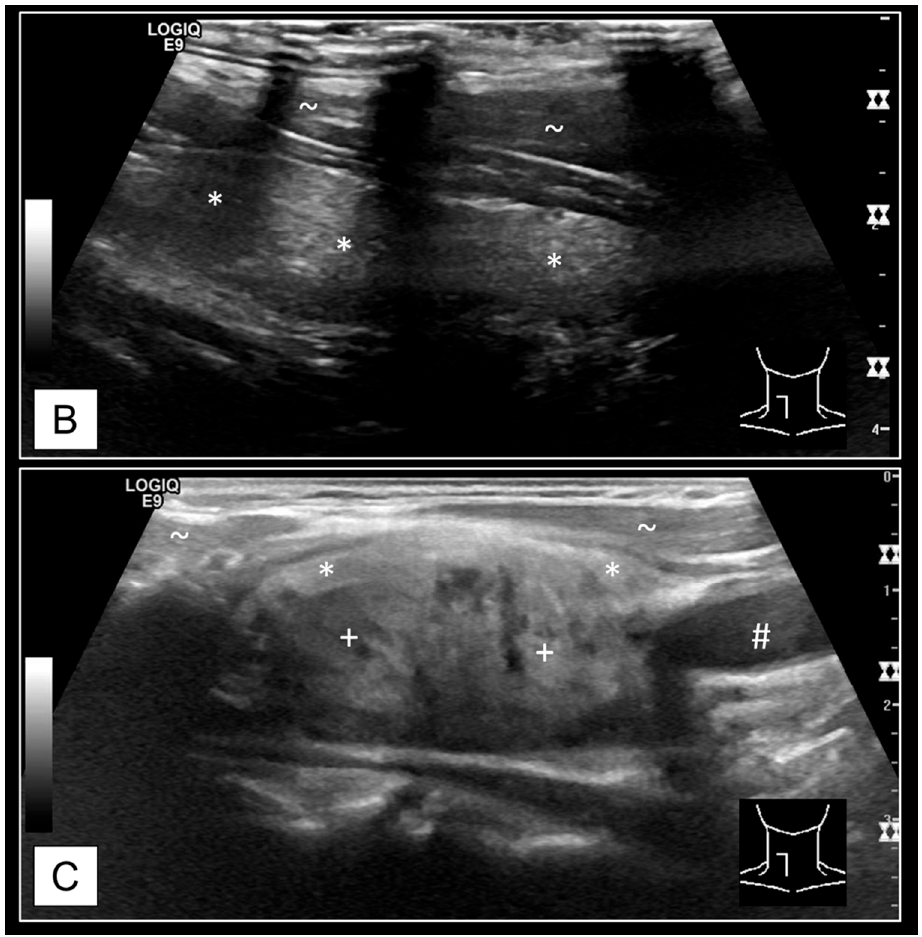
Figure 5. Examples for defiances on MTA US cine loops. ( A ) The caudal pole was missing; this is commonly due to breath-depending mobility of the thyroid gland. Patients should be asked to hold their breath during cine loop acquisition. ( B ) US artifacts caused by insufficient connectivity between the US probe and the patients’ skin via the applied ultrasonic gel. ( C ) Too fast movement of the US probe can lead to blurred images. This occurs especially with multiple depth foci ( n = 3 in this case). Separate US pulses are generated for every focus, influencing the image frame rate. Thus, thyroid nodule contours/ borders cannot be accurately assessed on single images. Labels: * thyroid tissue, + thyroid nodules (TN), # carotid artery, ~ muscle tissue.